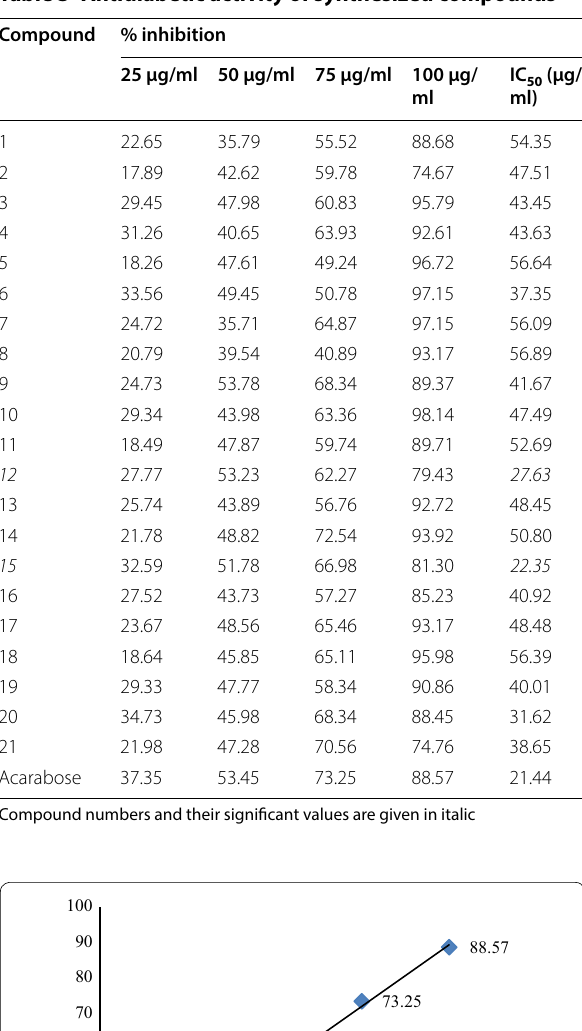
Table 3 Antidiabetic activity of synthesized compounds Compound % inhibition